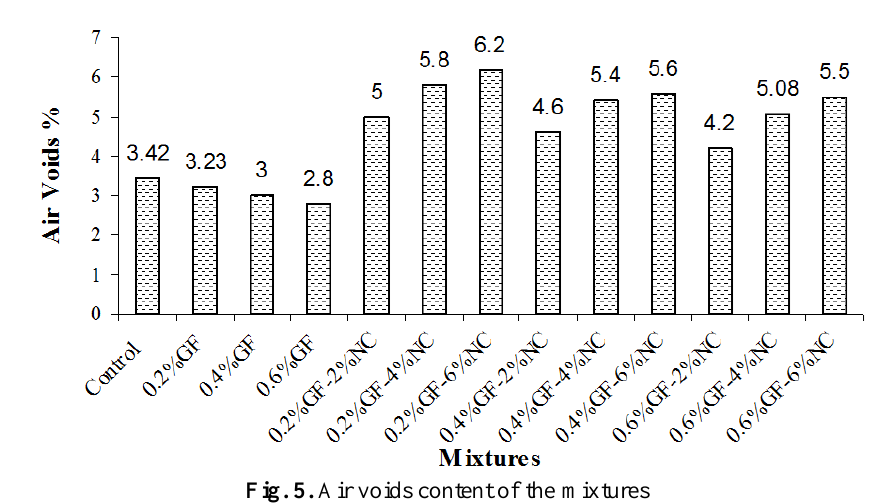
Fig. 5. Air voids content of the mixtures